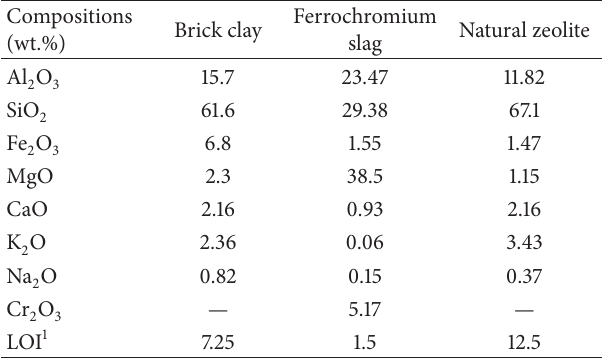
Table 2: Prepared mixtures from the raw materials used (wt.%). Brick Ferrochromium Natural Mix code clay slag